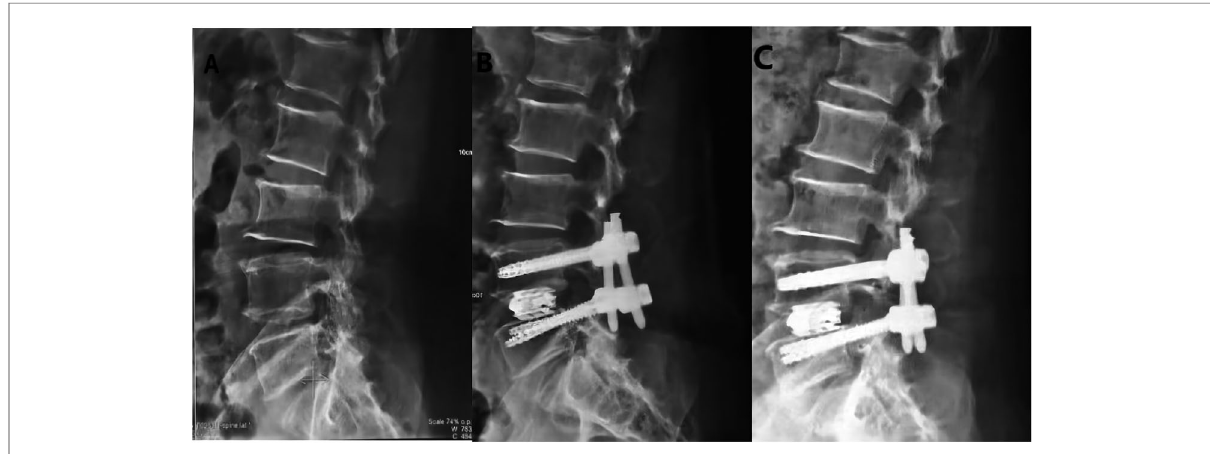
FIGURE 2 Design of EXP-IFC for anterior and Lateral display of Lumbar vertebrae after MIS-TLIF. ( A ) Preoperative lateral radiograph. ( B ) Postoperative lateral radiograph (1 week); ( C ) Postoperative lateral radiograph (1